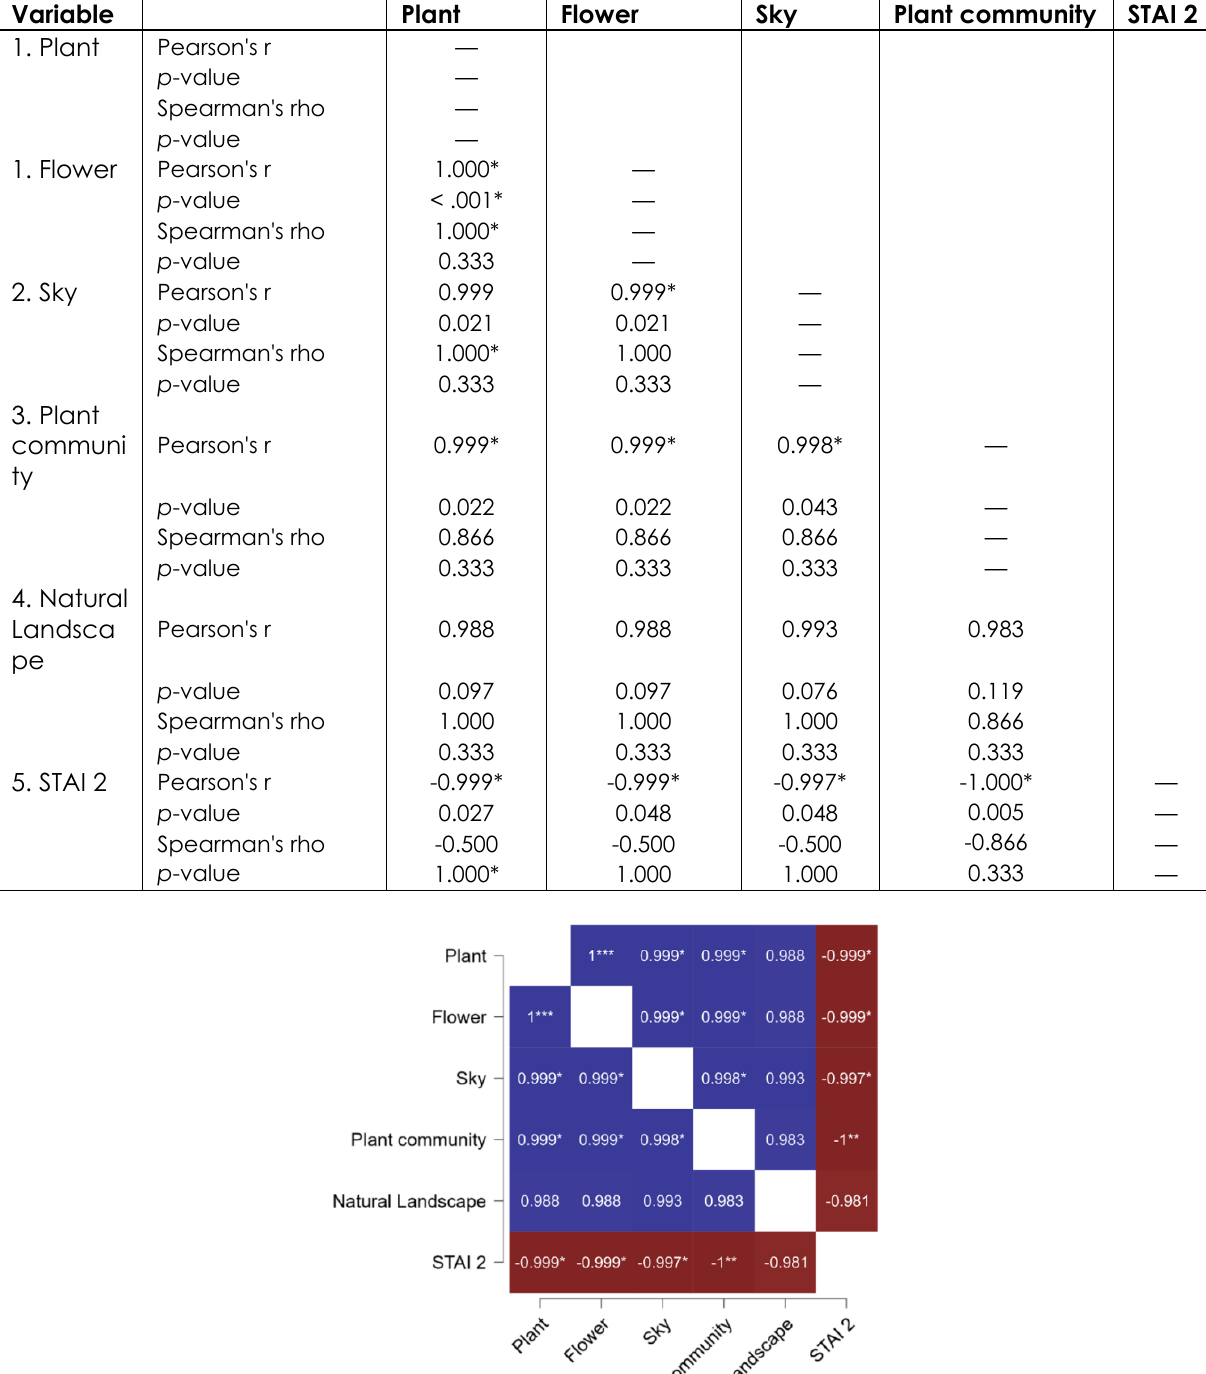
Table 3. Correlation Analysis between STAI and Landscape Elements.